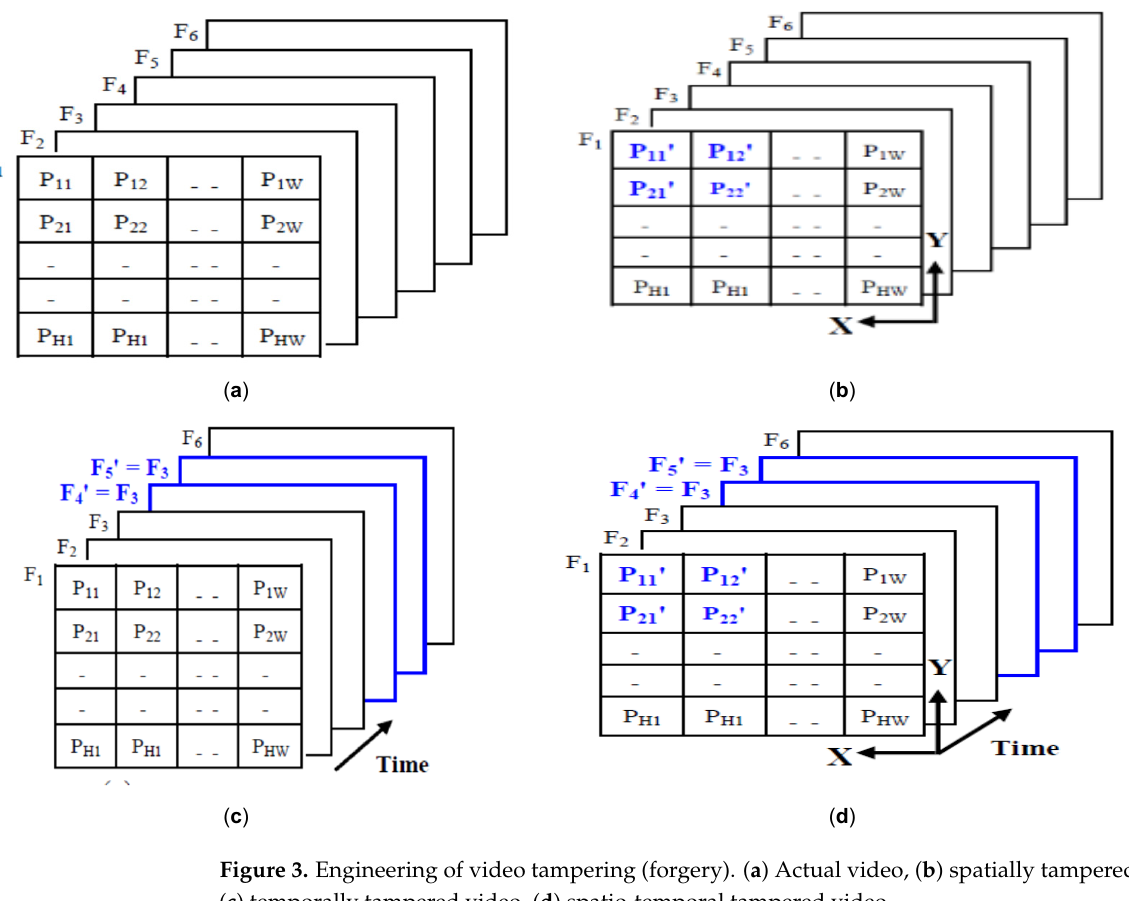
Figure 3. Engineering of video tampering (forgery). ( a ) Actual video, ( b ) spatially tampered video, ( c ) temporally tampered video, ( d ) spatio-temporal tampered video.